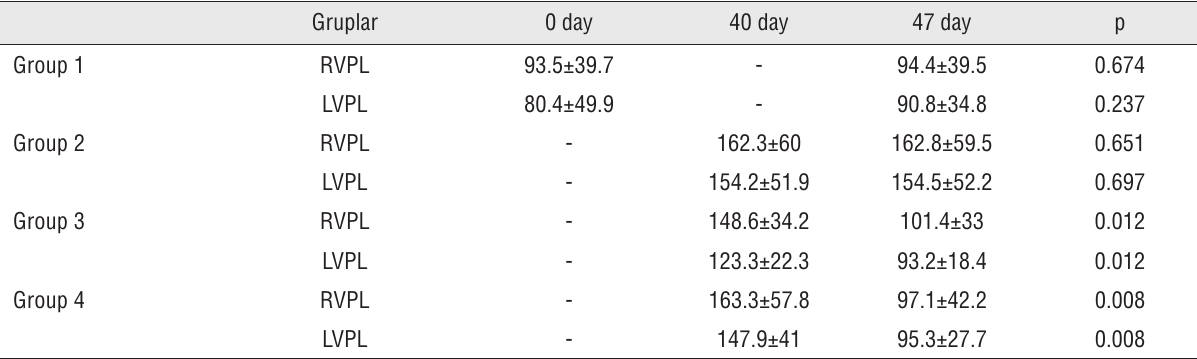
Table 1 - Epv measures made at different times and analysis of intra-group data.